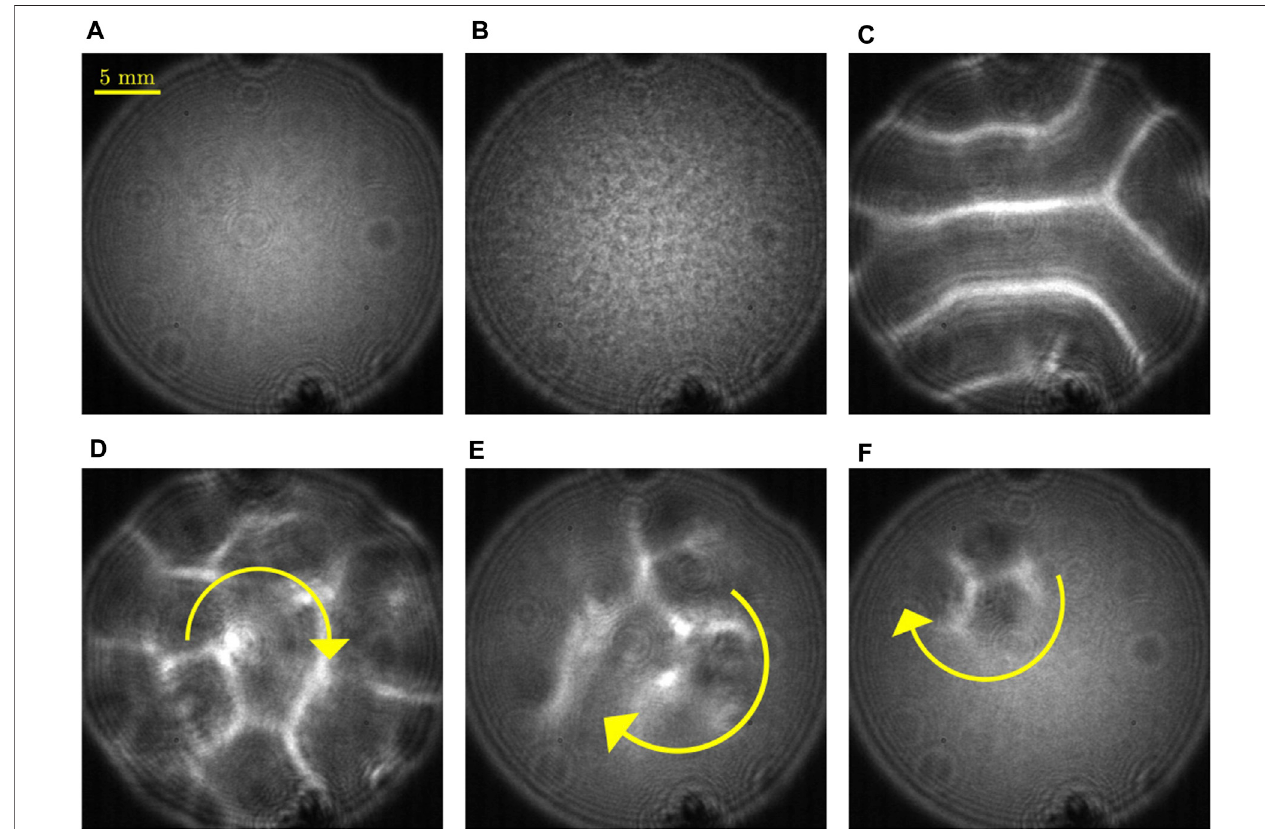
FIGURE2| Imagesequencerepresentingtheevolutionoftheconvectiveinstabilityina3.1 mmthicklayerofLUDOX TM TMA4%w/w. (A) atthebeginning,heating fromabovewithatemperaturedifferenceof10.5K,nomacroscopicmotionsarepresent; (B) afteratimeoftheorderoftensofminutessolutalconvectiondevelopsinthe cell; (C) after 1 h, the temperature difference is inverted and set to -4.13 K. In, approximatively 3 min thermal convective rolls appear in the sample; (D) the rolls, after a time that depends on the Rayleigh number, start to rotate; (E) they die out starting from the borders; (F) they gradually shrink in size, until they fi nally